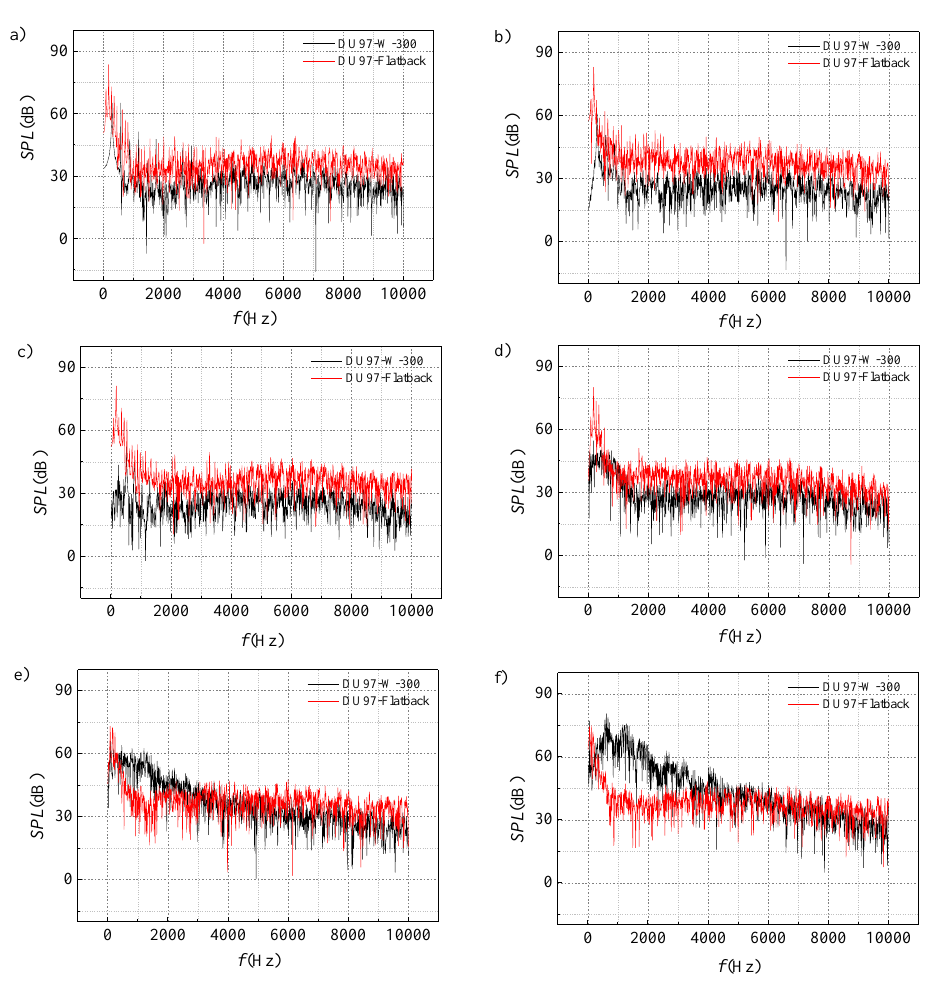
Figure 16. Distribution of SPL: ( a ) α = 0°, ( b ) α = 4°, ( c ) α = 8°, ( d ) α = 11°, ( e ) α = 15°, ( f ) α = 19°.